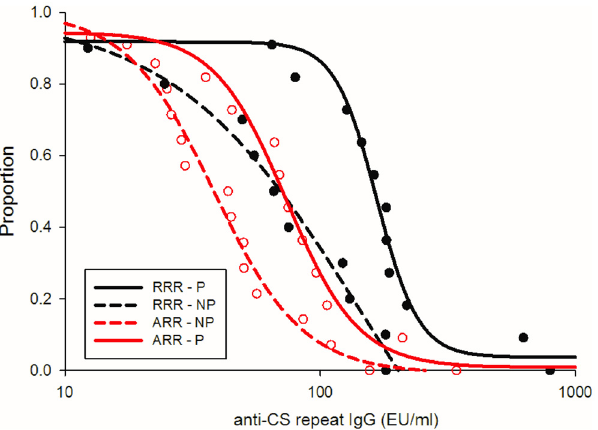
Fig 4. Reverse cumulative distribution curves by post challenge protection status for CS anti-repeat antibodies on day 77-Day of challenge for subjects in ARR protected (solid red) and non-protected (dashed red) compared to RRR protected (solid black) and non-protected (dashed black) subjects. Y - axis represents proportion of subjects at each antibody level. doi:10.1371/journal.pone.0131571.g004 There were no significant differences between protected and non-protected subjects in IFN- γ secretion by CS-specific T cells in ELISpot assay for the entire cohort (p = .285), nor were there any differences detected in ELISpot assays when subgroups (ARR, p = .233; RRR, p = .827) were analyzed. No significant differences at DoC in CD4 + T cell responses analyzed by ICS were observed in protected compared to non-protected subjects when analyzed together (p